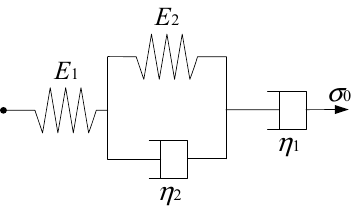
Figure 2. Schematic representation of Burgers model.